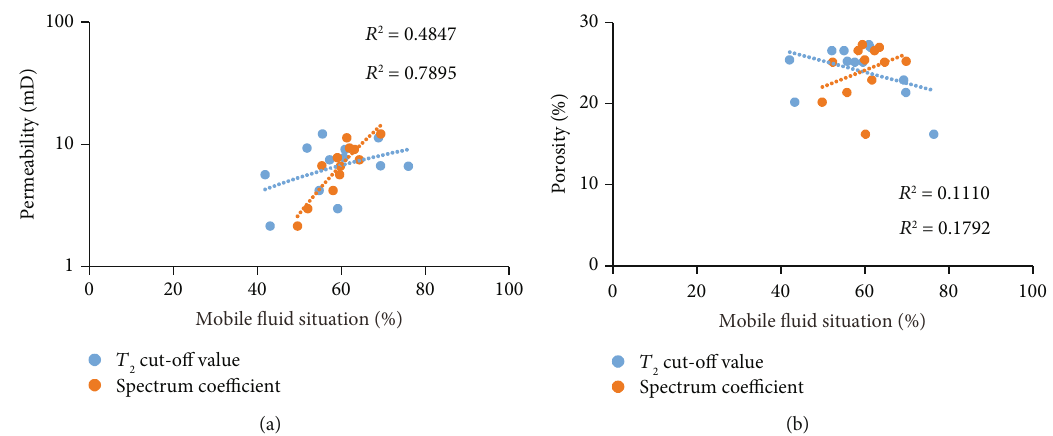
Figure 10: (a) Correlation of NMR movable fl uid saturation and permeability calculated by two methods. (b) Correlation analysis of NMR movable fl uid saturation and porosity calculated by two methods.